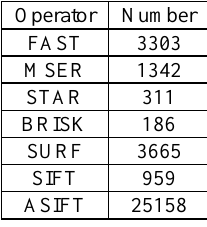
Table 1. Number of detected key-points.